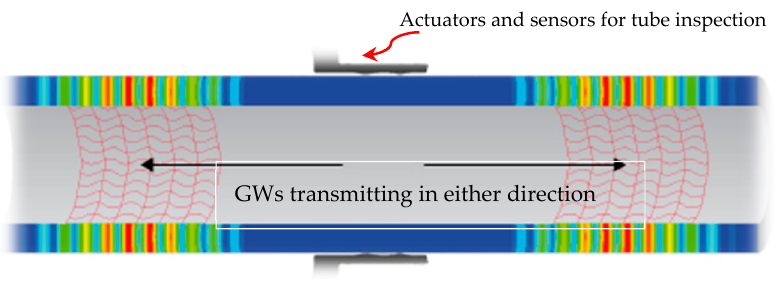
Figure 8. GWs inspection of a metallic pipeline structures [96].